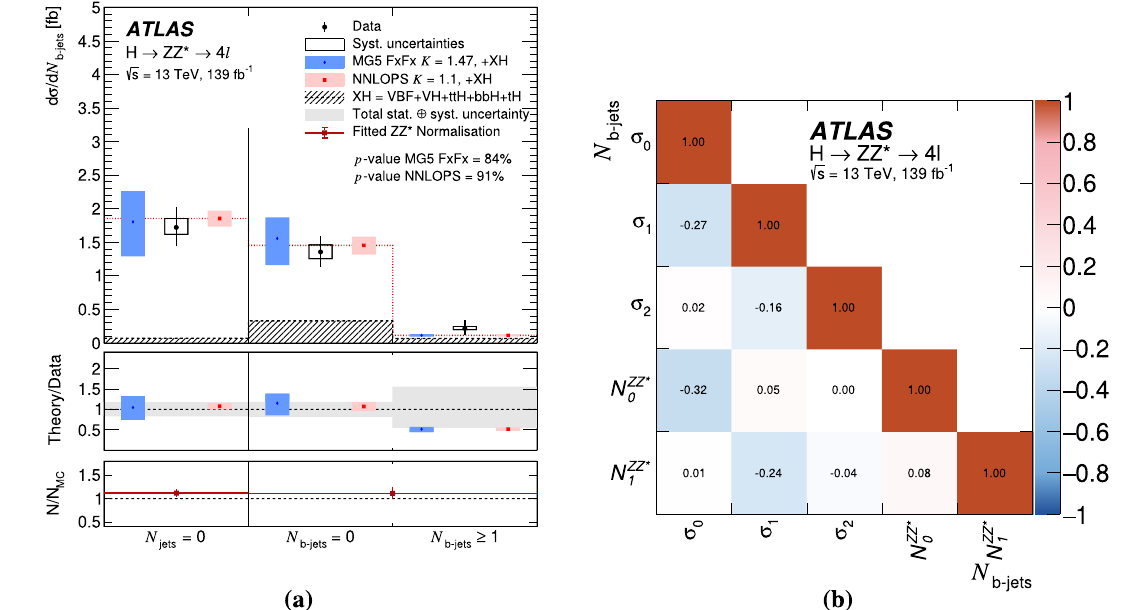
Fig. 25 a Differential fiducial cross section as function of the b -jet multiplicity, N b - jets . Three bins are considered. The first bin is filled with events which do not have any jets, the second is filled with events with at least one jet but no b -tagged jets, while the third includes all